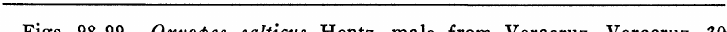
Figs. 98-99. Oxyopes salticus Hentz, male from Veracruz, Veracruz, 30 July 1972. 98. Left palpus, retrolateral view. 99. Left palpus, ventral view. Figs. 100-101. Oxyopes ocelot new species, male holotype from. W side of Lake Sayula, Guerrero, 3 Aug. 1956. 100. Retrolate.ral view. 101. Ven- tral view. Figs. 102-103. Oxyopes elinus Brady, male from SW of Aeaponeta, Nayarit, 15 May 1963. 102. Retrolateral view. 103. Ventral view. Figs. 104-105. Oxyopes cornutus F.O.P.-Cambridge, male from 8 mi. SW of Colima, Colima, 10 May 1963. 104. Retrolateral view. 105. Ventral